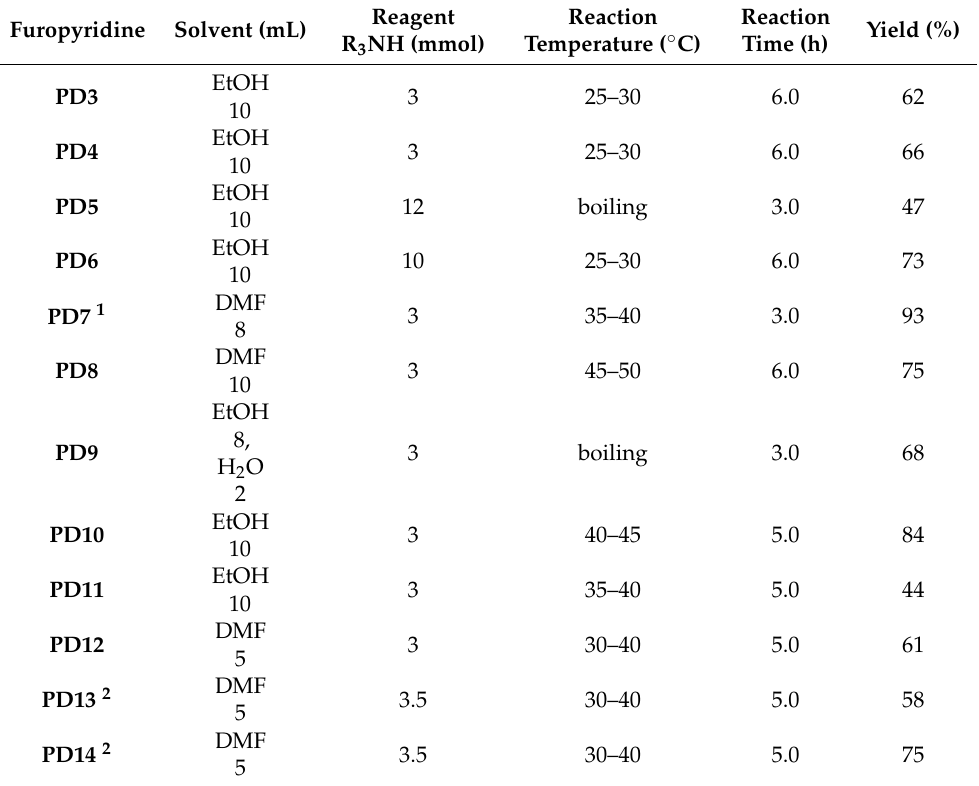
Reaction Yield (%) Time (h)